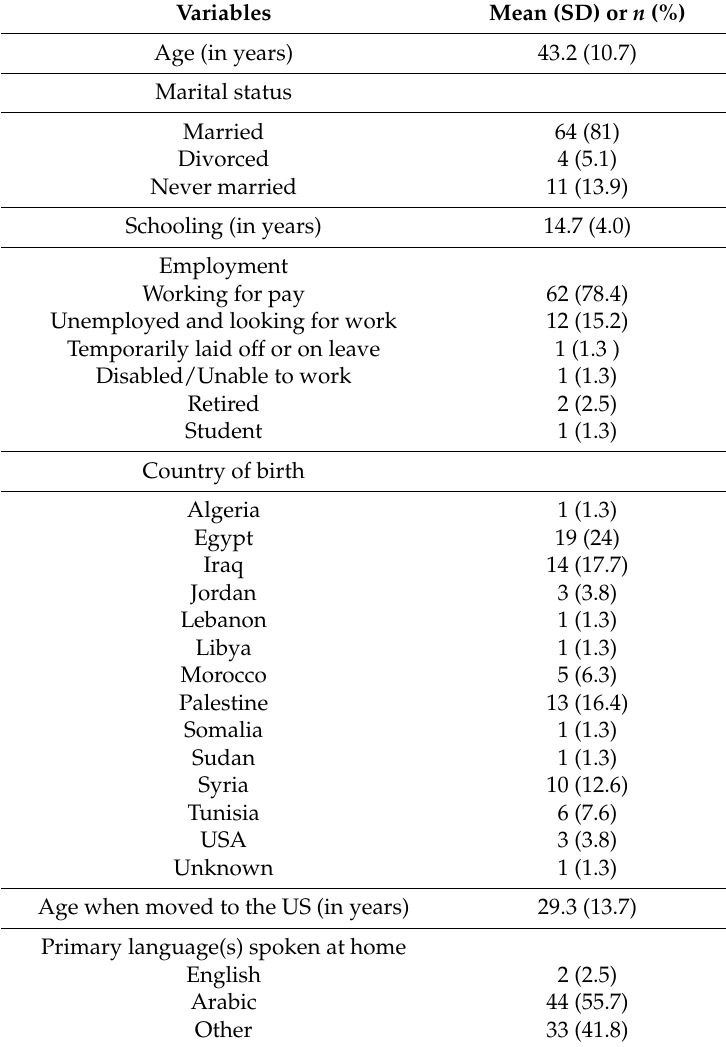
Table 1. Demographic Characteristics ( n =